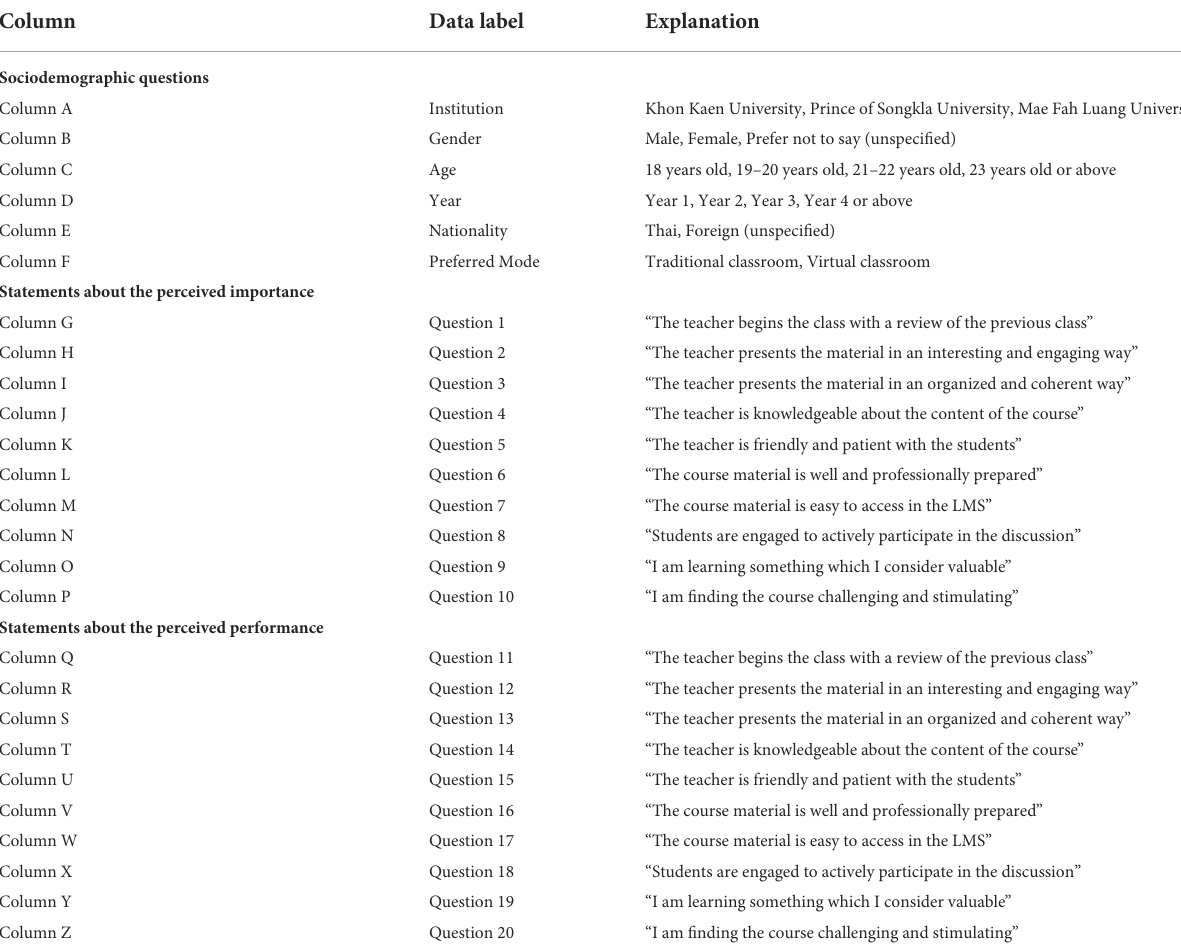
TABLE 5 Description of the characteristics in the dataset [adopted from the original study by Fuchs and Karrila (2021)]. Column Data